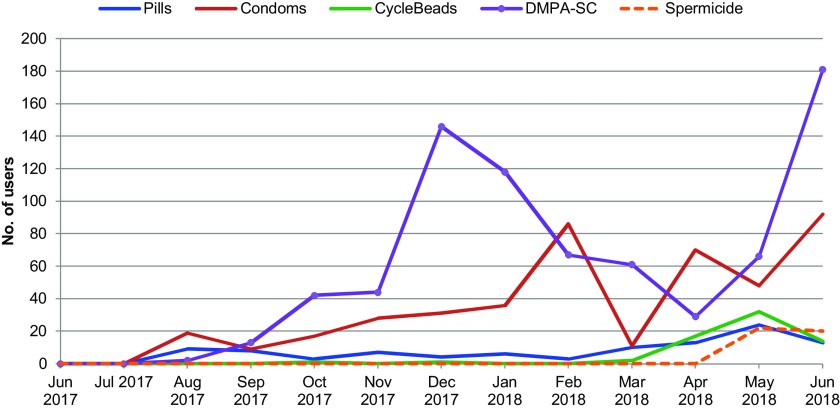
Number of Family Planning Users Switching to a New Method at the Community Level, by New MethodAbbreviation: DMPA-SC, subcutaneous depot medroxyprogesterone acetate.